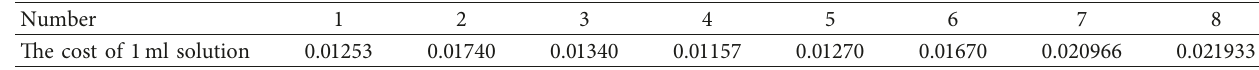
Table 2: Cost of 1 ml solution when each formula is configured into 100ml solution.